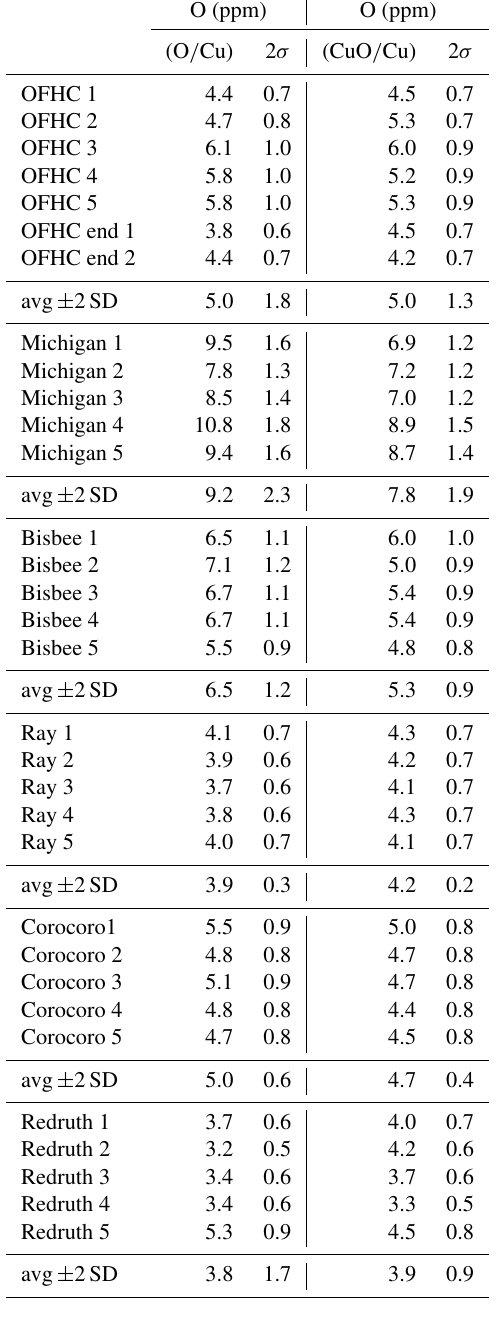
Table 3. Oxygen concentration in